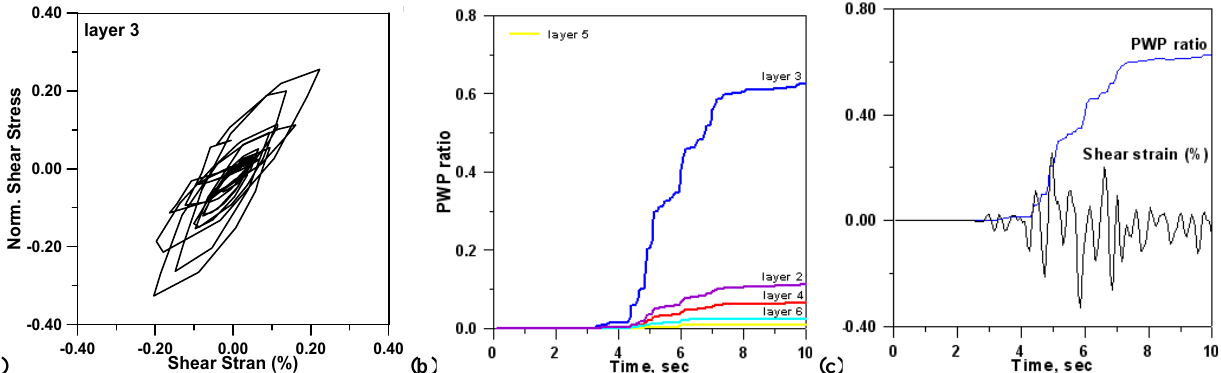
Fig. 24. Stress-strain history (a) for the layer with high probability to liquefy; PWP time histories at different ground level (b ; PWP and . shear strain time histories (c) for the layer with high probability to